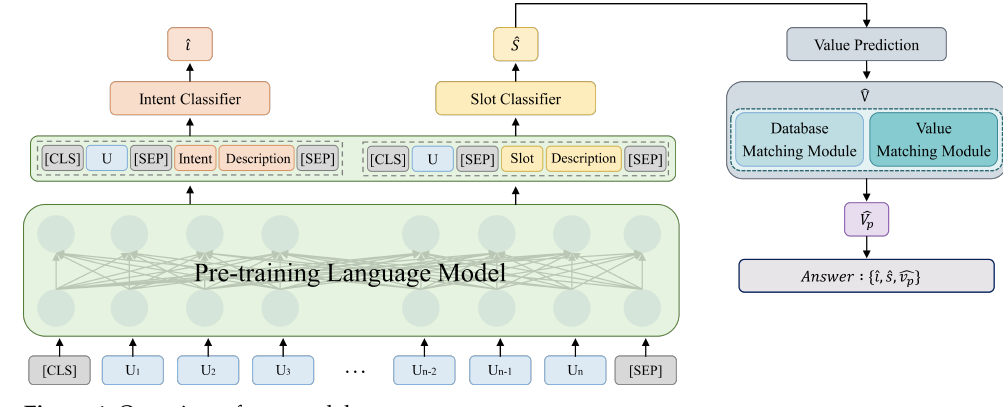
Figure 1. Overview of our